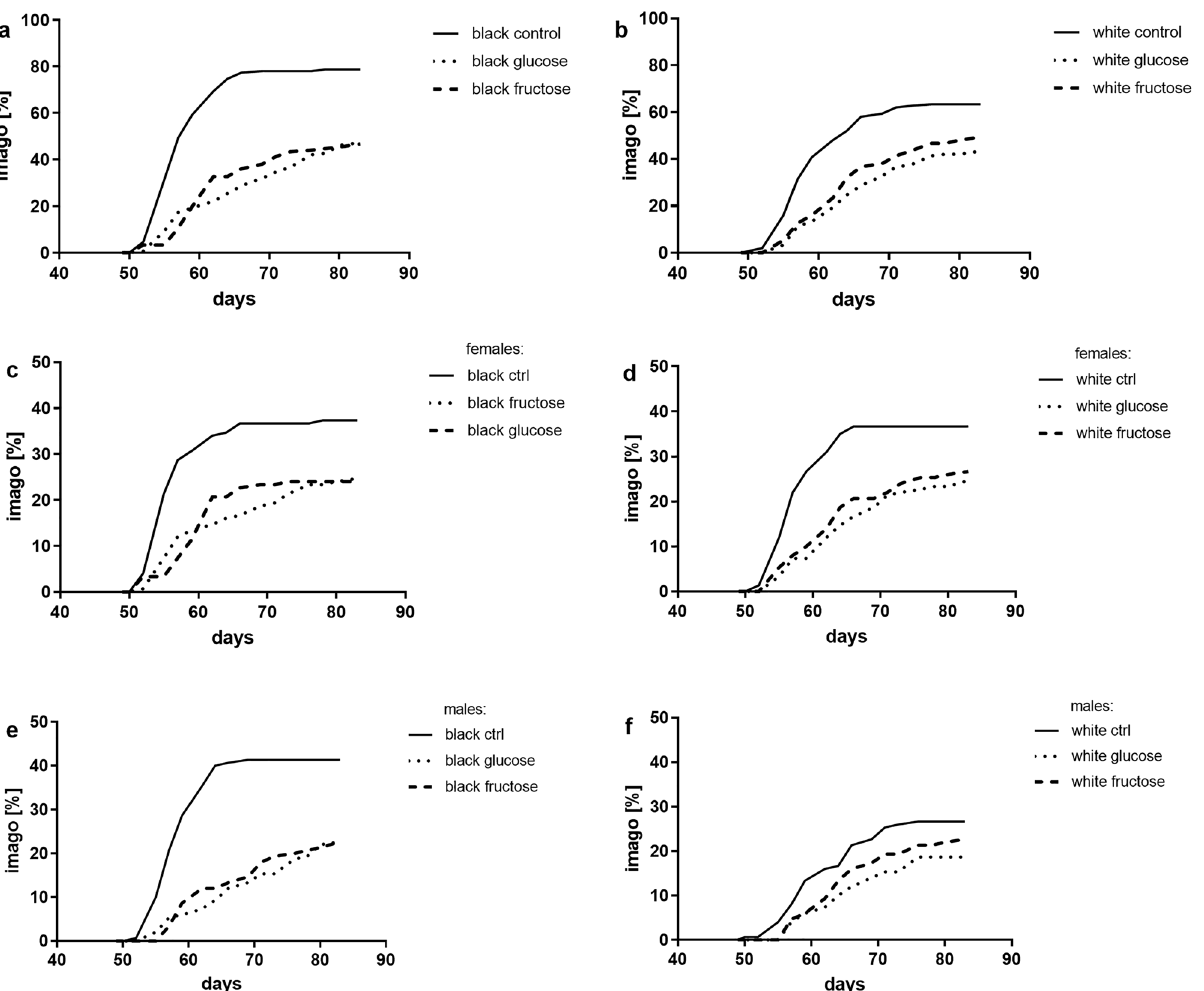
Figure 4. The success of imago stage reaching presented as cumulative percentage curves: ( a ) black-eyed strain, ( b ) white-eyed strain, ( c ) black-eyed strain females, ( d ) white-eyed females, ( e ) black-eyed strain males, ( f ) white-eyed